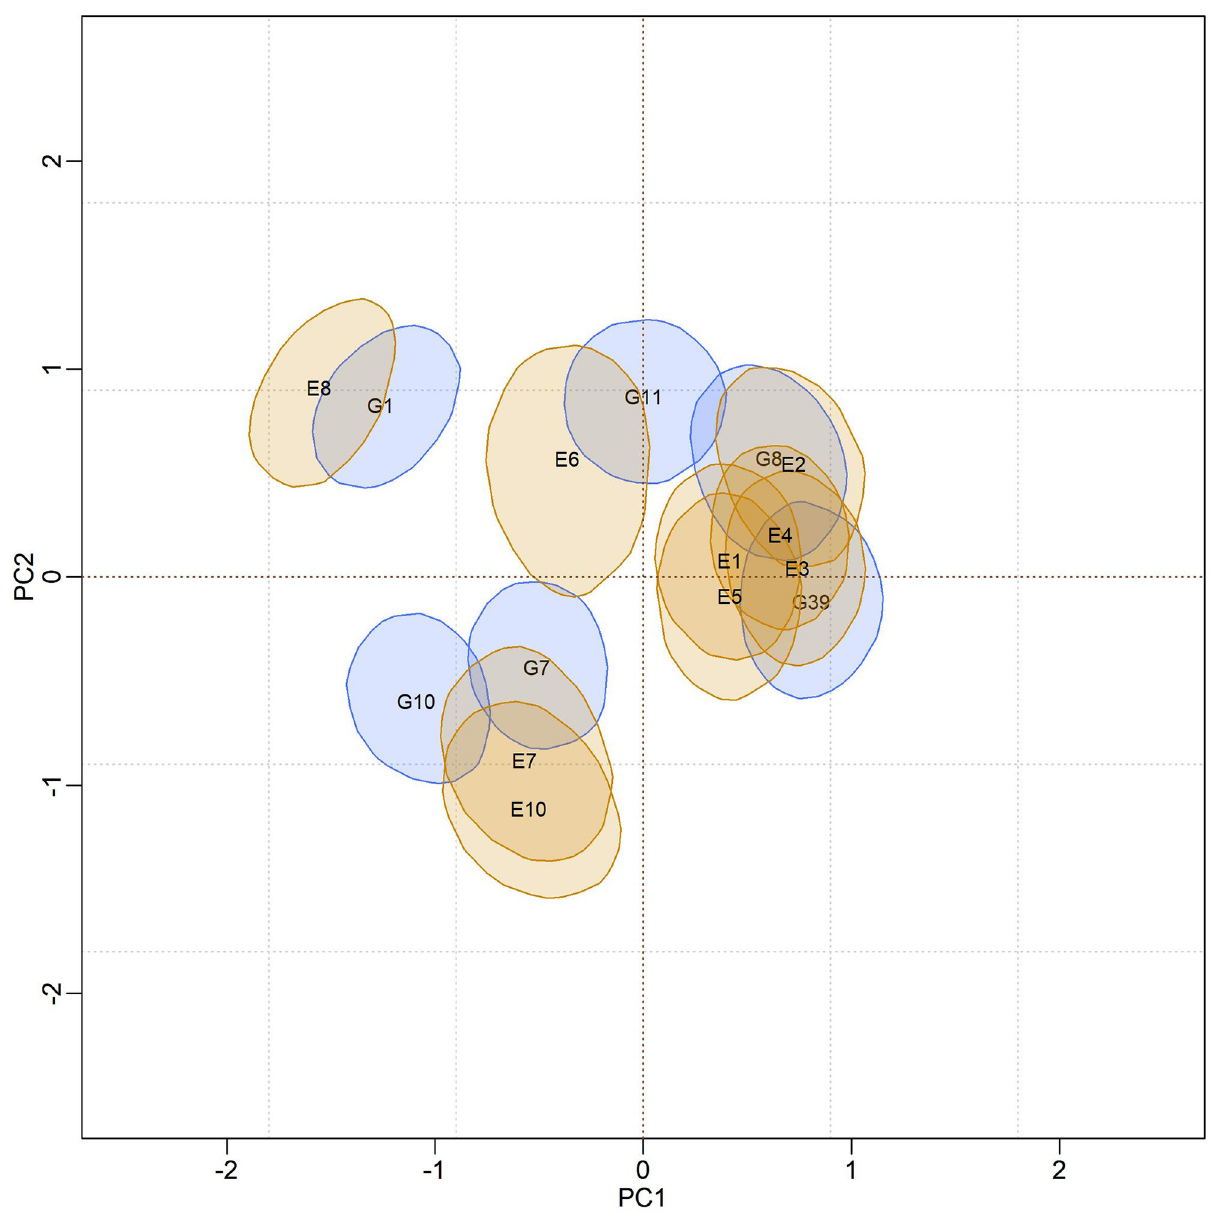
Fig 19. Bivariate credibility regions at 95% probability for the genotypic and environmental scores of the BAMMIE-3 model for real data, adjusted using the MCMC method. Only regions whose regions do not contain the origin (0.0) were plotted.